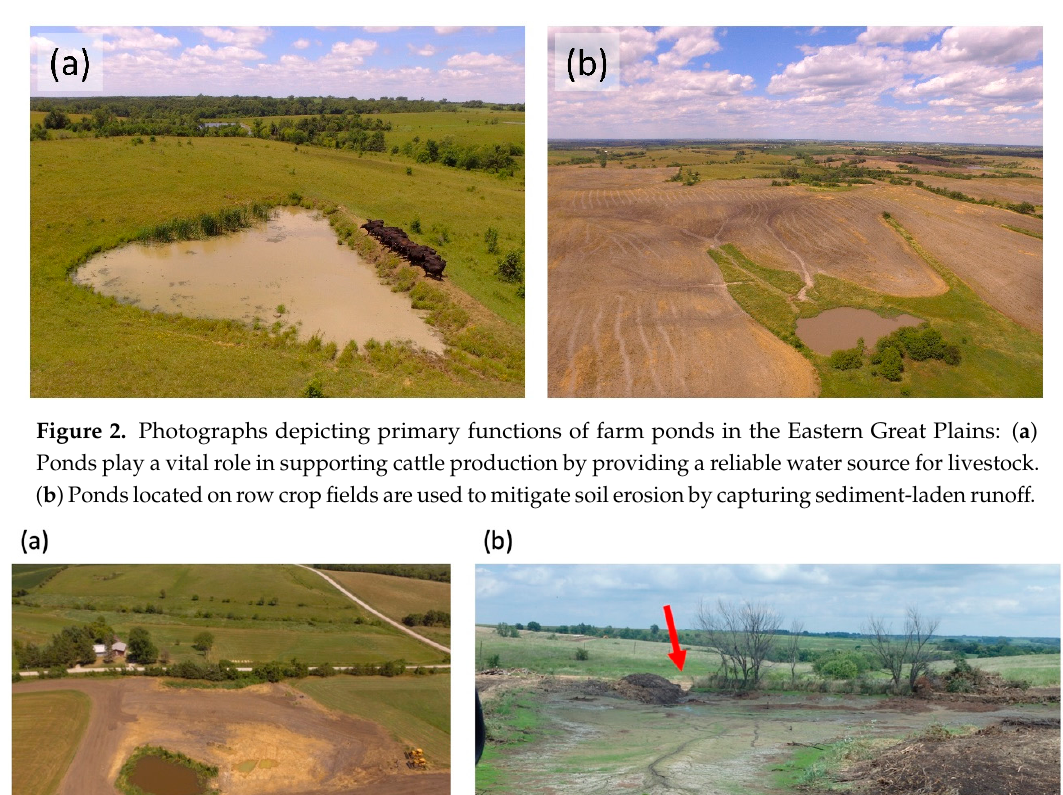
Figure 2. Photographs depicting primary functions of farm ponds in the Eastern Great Plains: ( a ) Ponds play a vital role in supporting cattle production by providing a reliable water source for livestock. ( b ) Ponds located on row crop fields are used to mitigate soil erosion by capturing sediment- laden runoff.